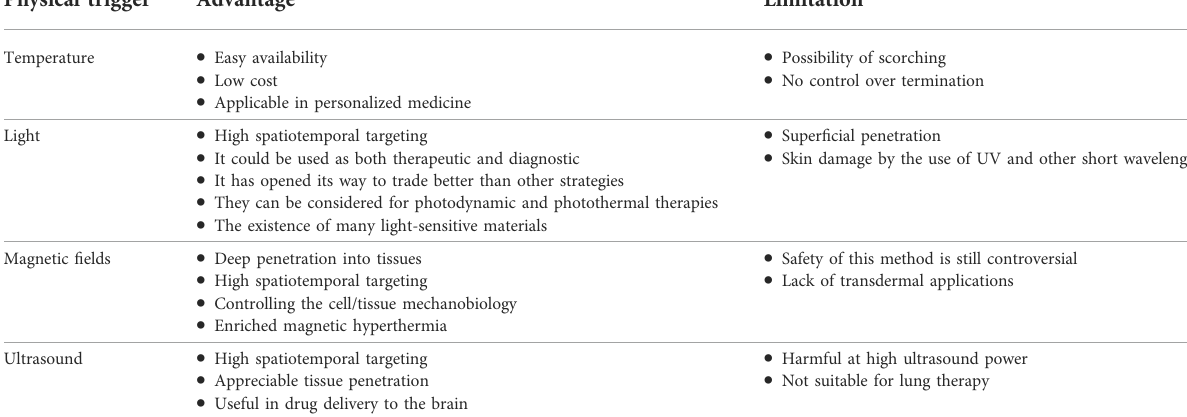
TABLE 6 Advantages and limitations of physically triggered systems for therapy and